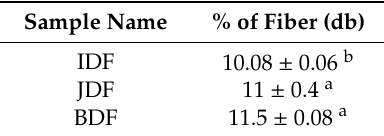
Table 1. Percent of undigested raw material from fresh